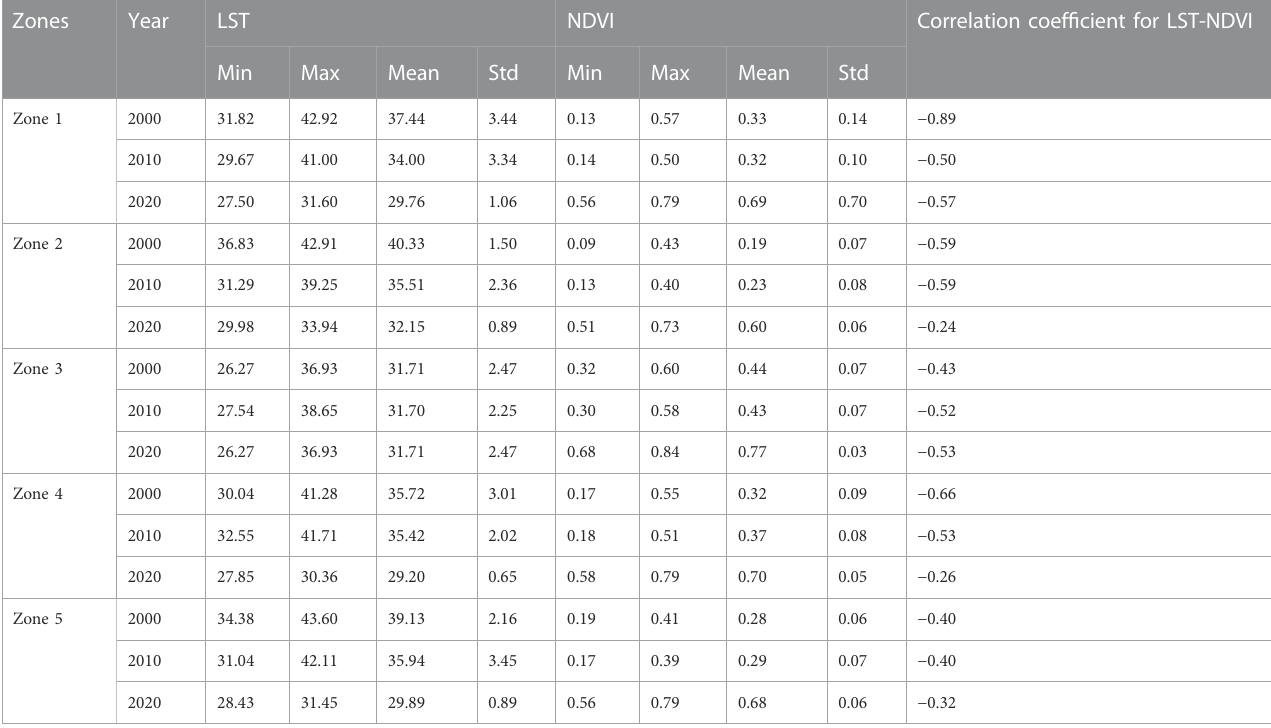
TABLE 4 The statistical description of temporal variation of LST, NDVI, and LST-NDVI relationship for the period 2000 –